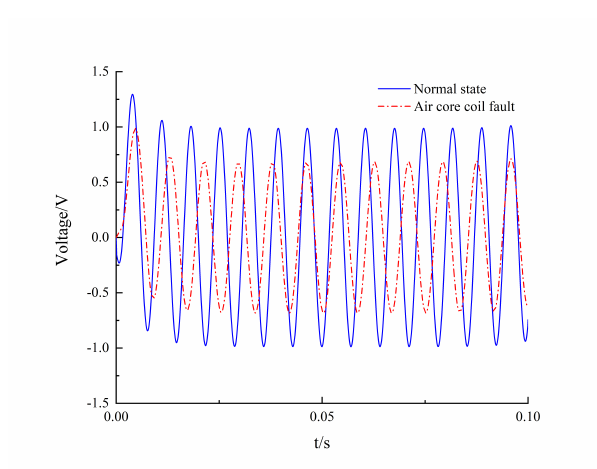
Fig. 13. Voltage response of receiving terminal when the train leaves.